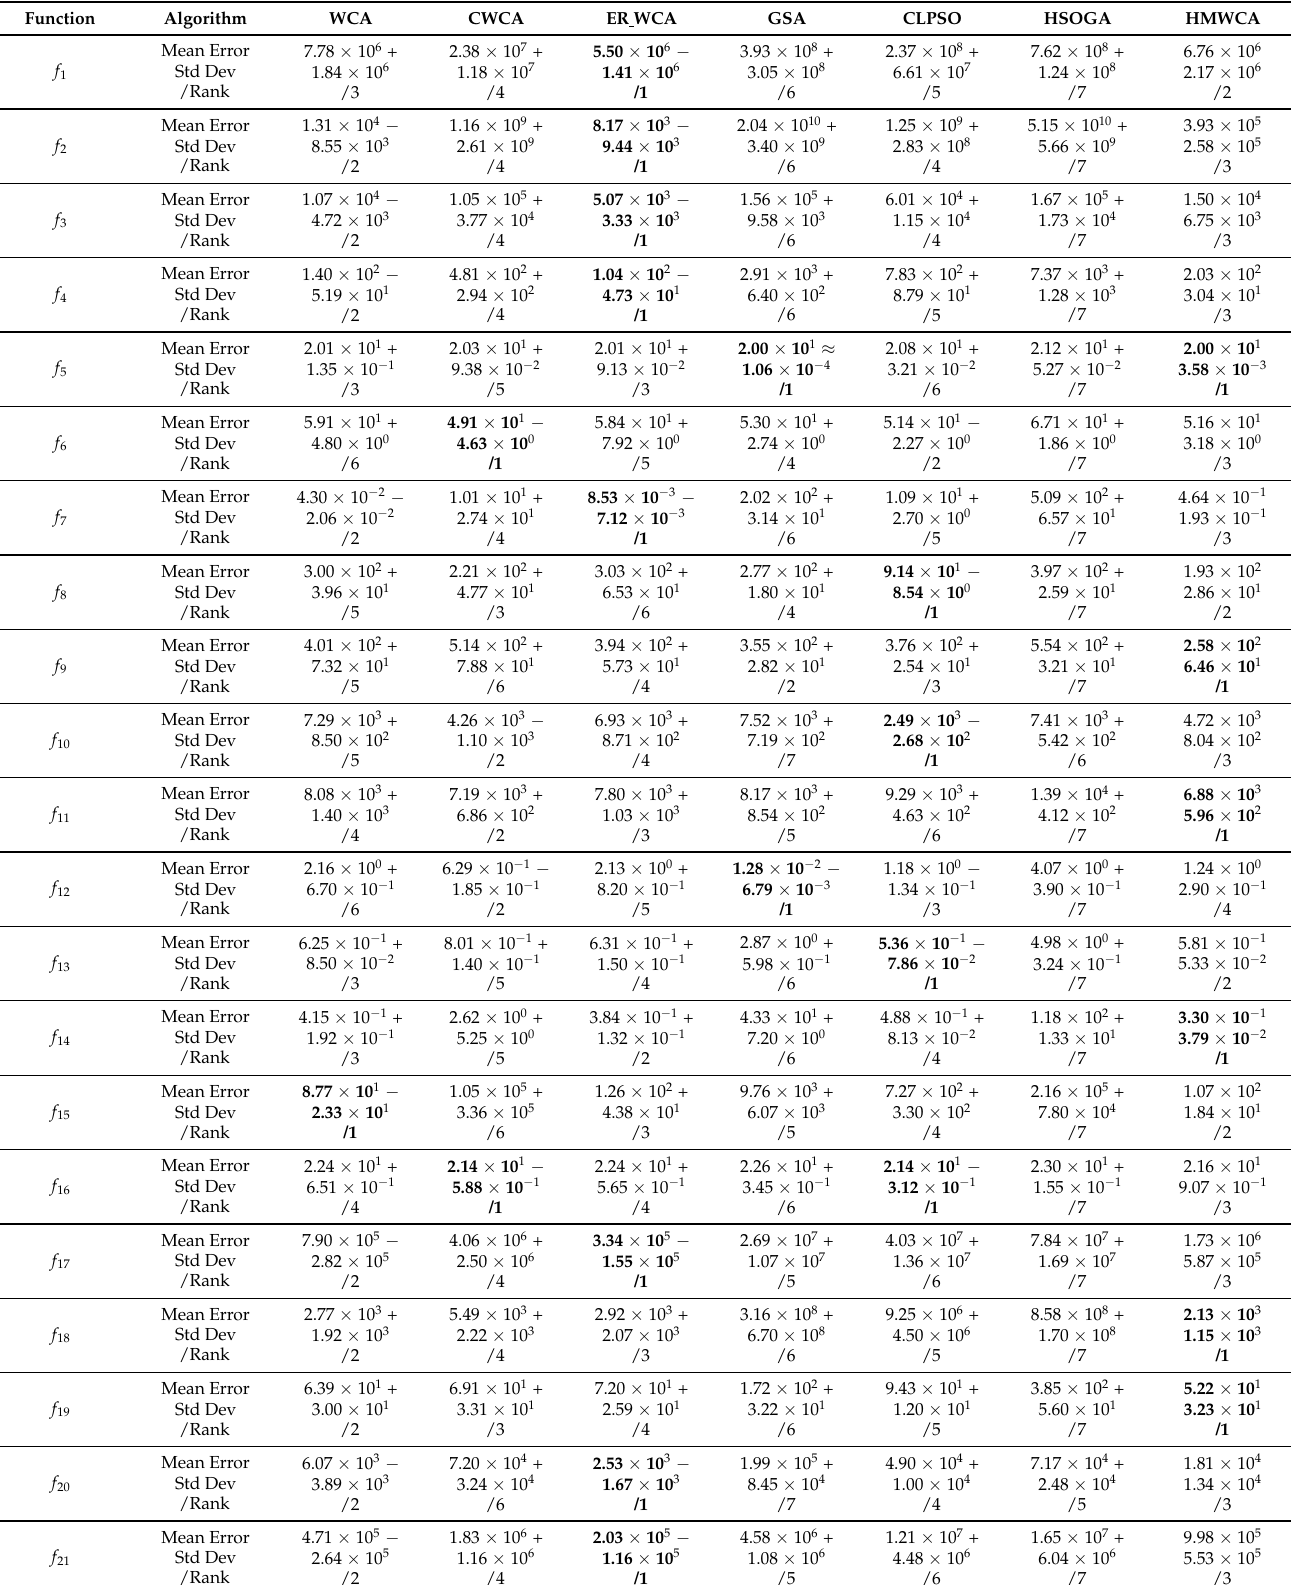
Table 5. Experimental results of the HMWCA and six well-known algorithms on the CEC 2014 functions with D =